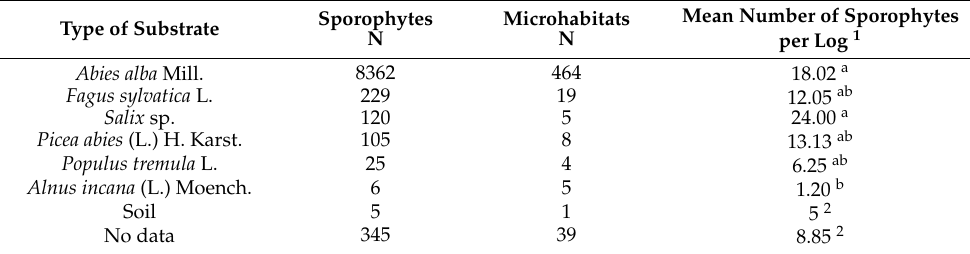
Table 4. Occurrence of Buxbaumia viridis on different types of substrate.